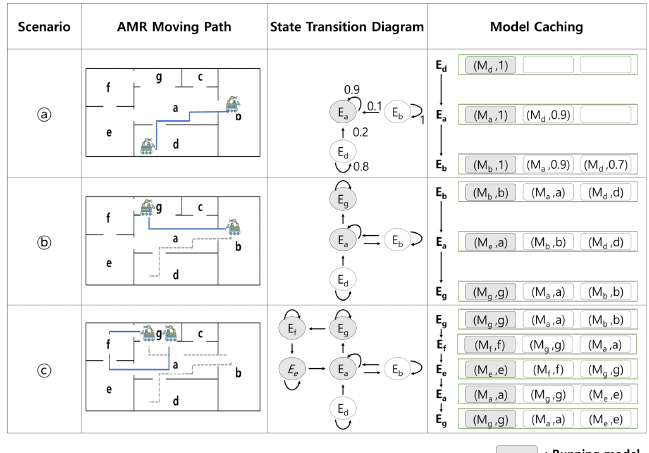
Figure 7. Example of transition probability-based model caching (cache size = 3).